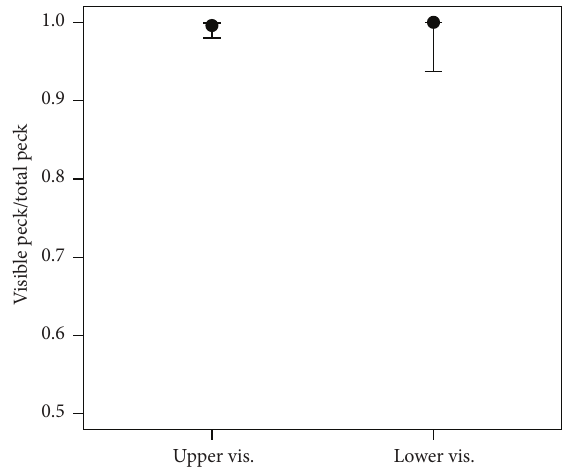
Figure 3: The probability of pecking the clear part of a two-part bag, with half clear and half white. Fruits were covered with half- clear bags in which the upper or lower half was opaque (half-visible bag;seeFigure 1).Theprobabilitieswereestimatedaspeckingcounts on the clear part divided by the total pecking count. The 𝑥 -axis shows the treatment; “upper vis.” and “lower vis.” mean that the upper or lower half part was the clear part, through which fruit were visible. Error bars indicate 95% confidence intervals (GLMM; error distribution: